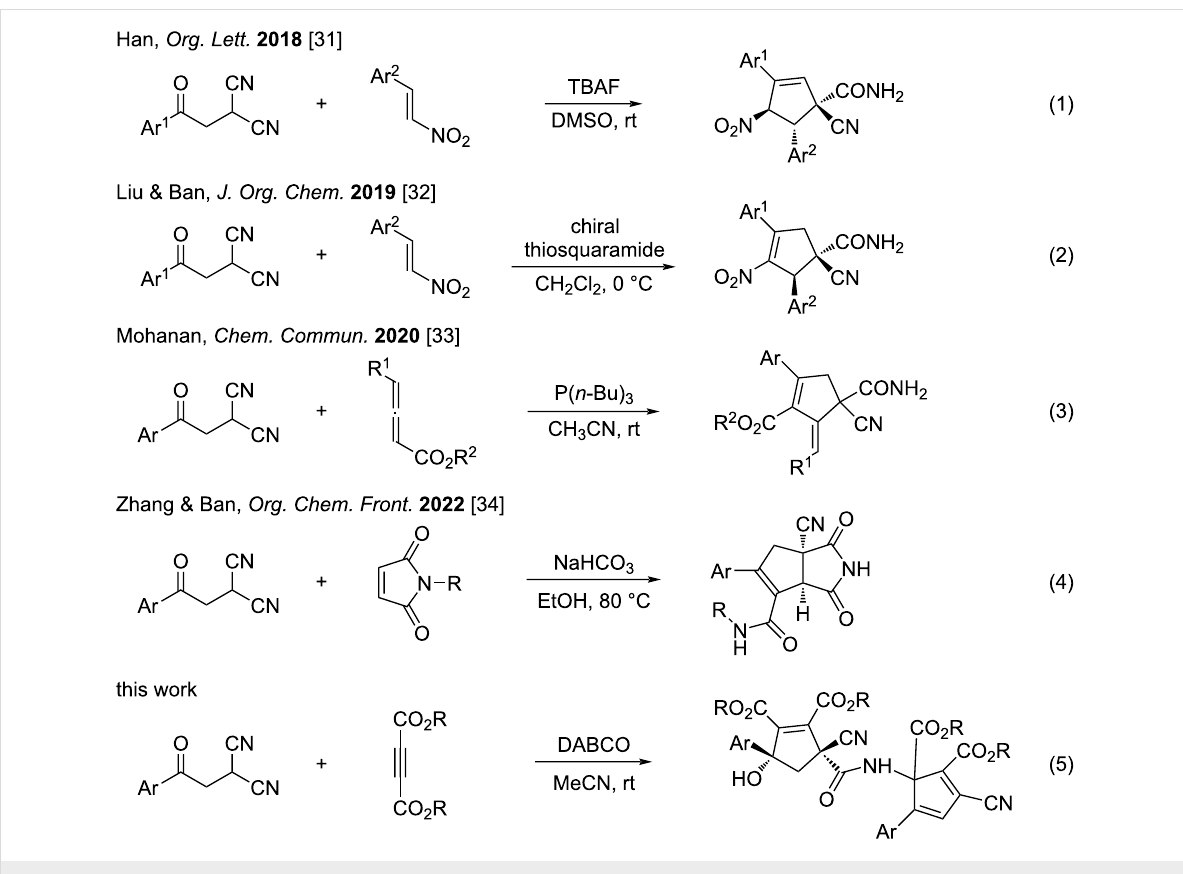
Scheme 1: Representative cycloaddition reactions of